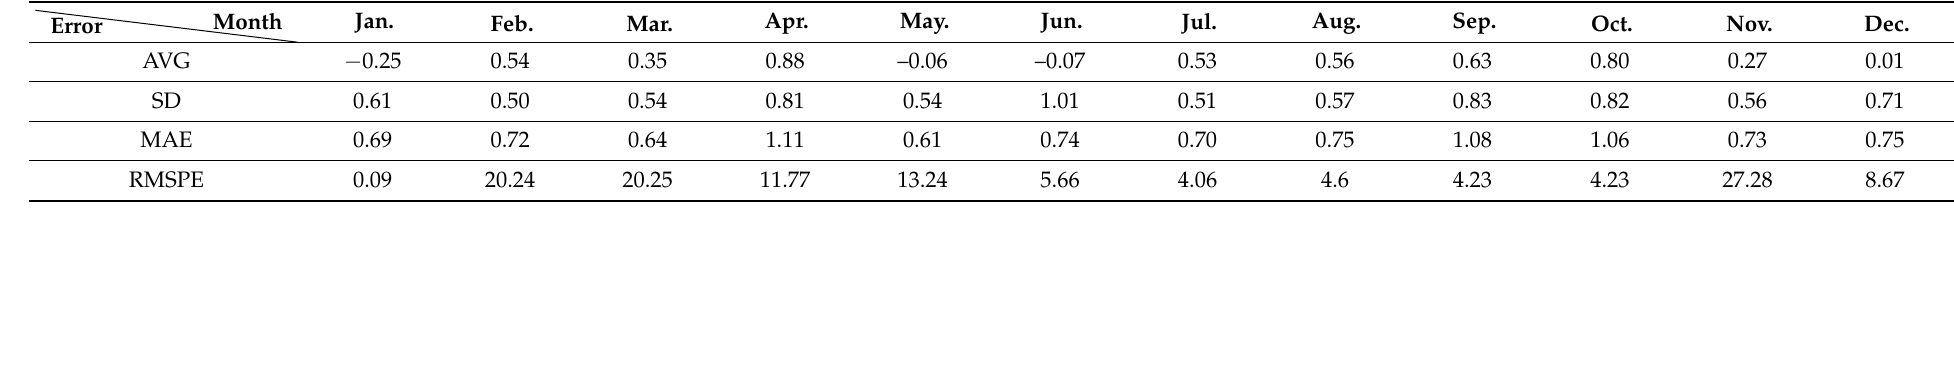
Table 3. Restoration error metrics ( ◦ C) such as AVG, SD, MAE, and RMSPE for 12 months.